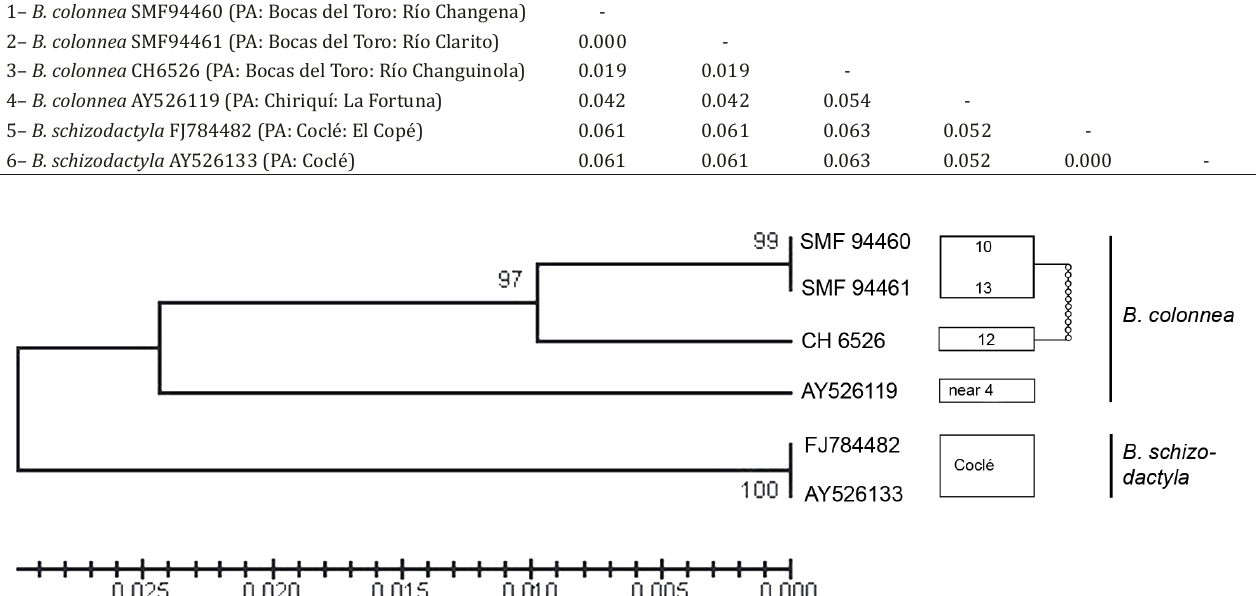
Estimates of evolutionary divergence between sequences of specimens of an outgroup. The number of base substitutions per site from between sequences are shown. Analyses were conducted using the Tamura 3-parameter